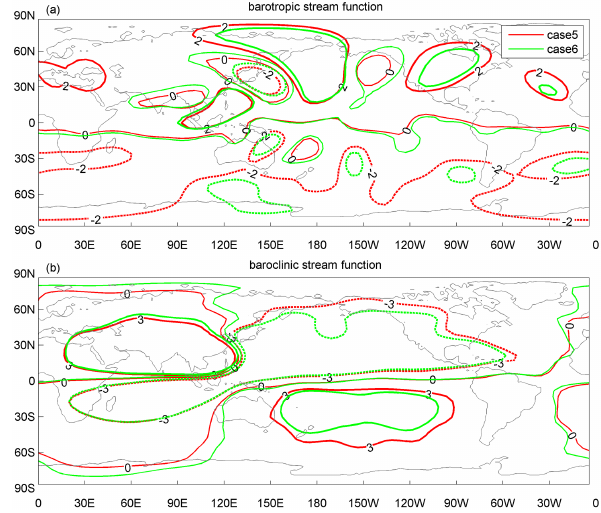
Figure 7. (a) Barotropic and (b) baroclinic stream function anoma- lies (10 6 m 2 s − 1 ) for cases 5 (red) and 6 (green). The contour in- terval is 2 × 10 6 m 2 s − 1 in the top panel and 3 × 10 6 m 2 s − 1 in the bottom